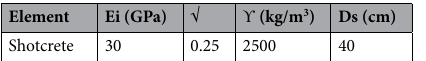
Table 9. Parameters used for shotcrete lining concrete.